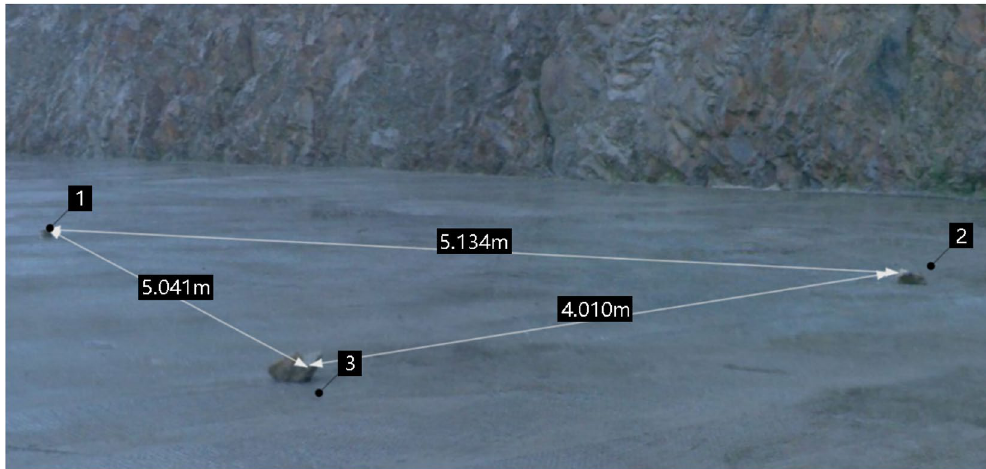
Figure 7. Earth coordinate points scanned by the 3D laser scanner.